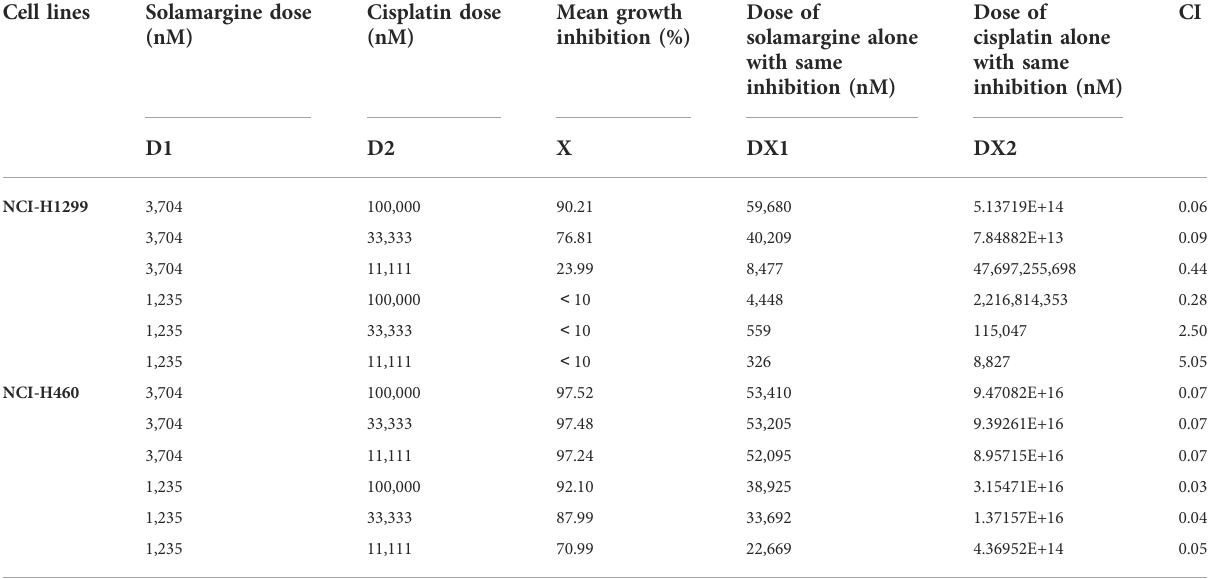
TABLE 2 Combination index (CI) of Solamargine and Cisplatin in H1299 and H460. Cell